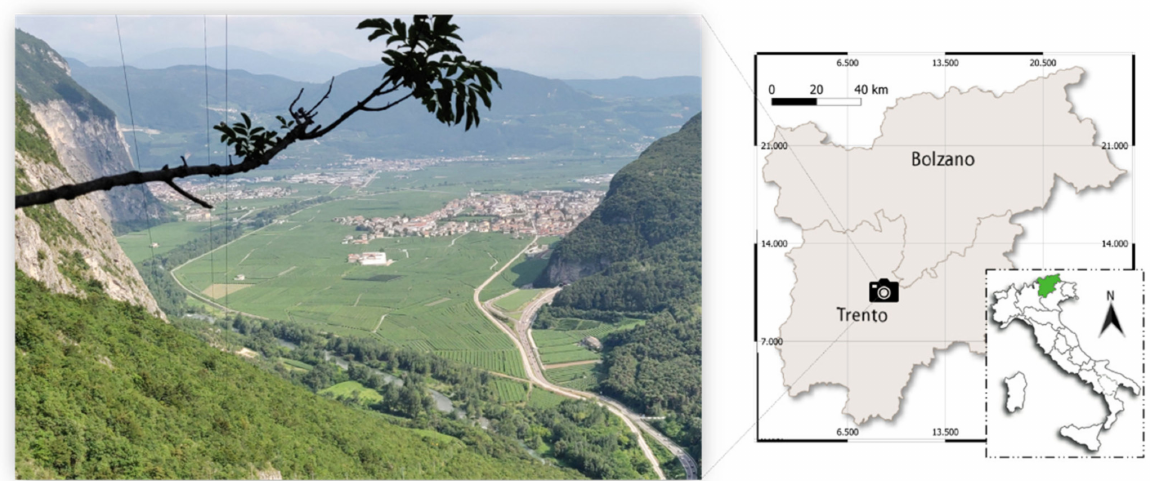
Figure 2. Photo of the winegrowing region Piana Rotaliana located in Trentino region in the northeast side of Italy. From the author, Tor di Visione, (TN), 26 July